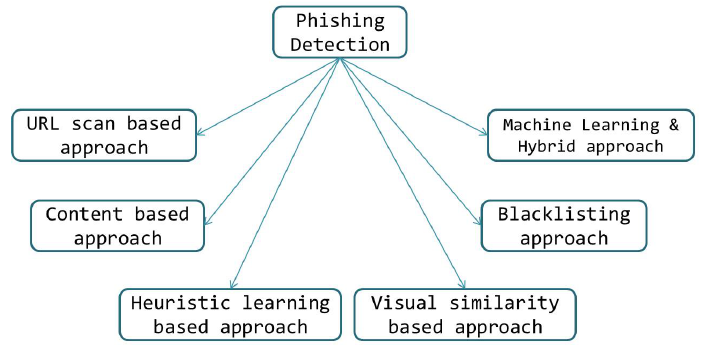
Figure 1. Categorization of phishing attack detection [2].